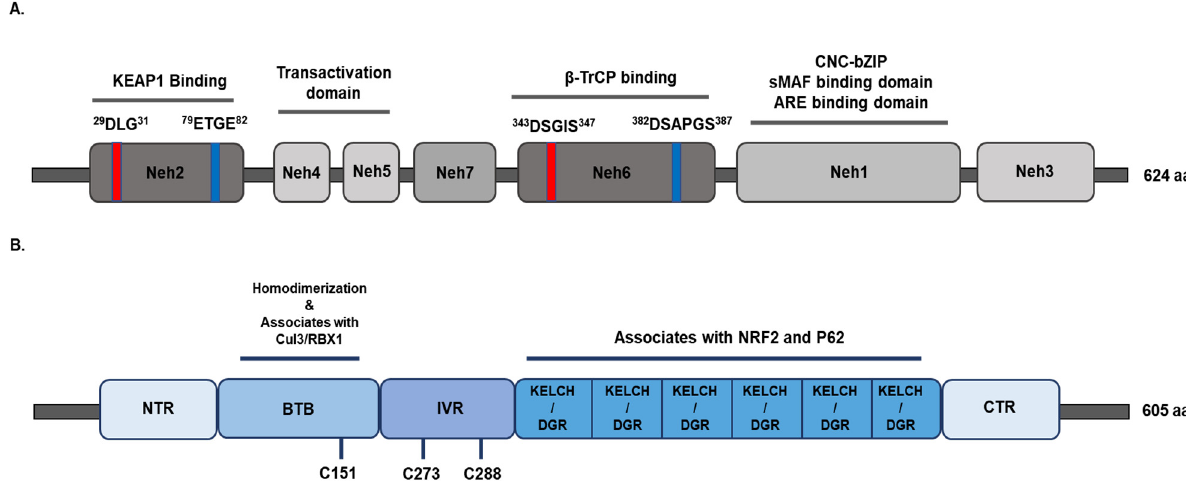
Figure 1. Domain structures of nuclear factor erythroid 2-related factor 2 (NRF2) and Kelch-like-ECH-associated protein 1 (KEAP1). ( A ) The relative positions of NRF2-ECH homology (Neh) domains, Neh1-Neh7, are indicated. The N-terminal Neh2 domain contains DLG and ETGE motifs, which interact with KEAP1. The Neh3, Neh4, and Neh5 domains are known